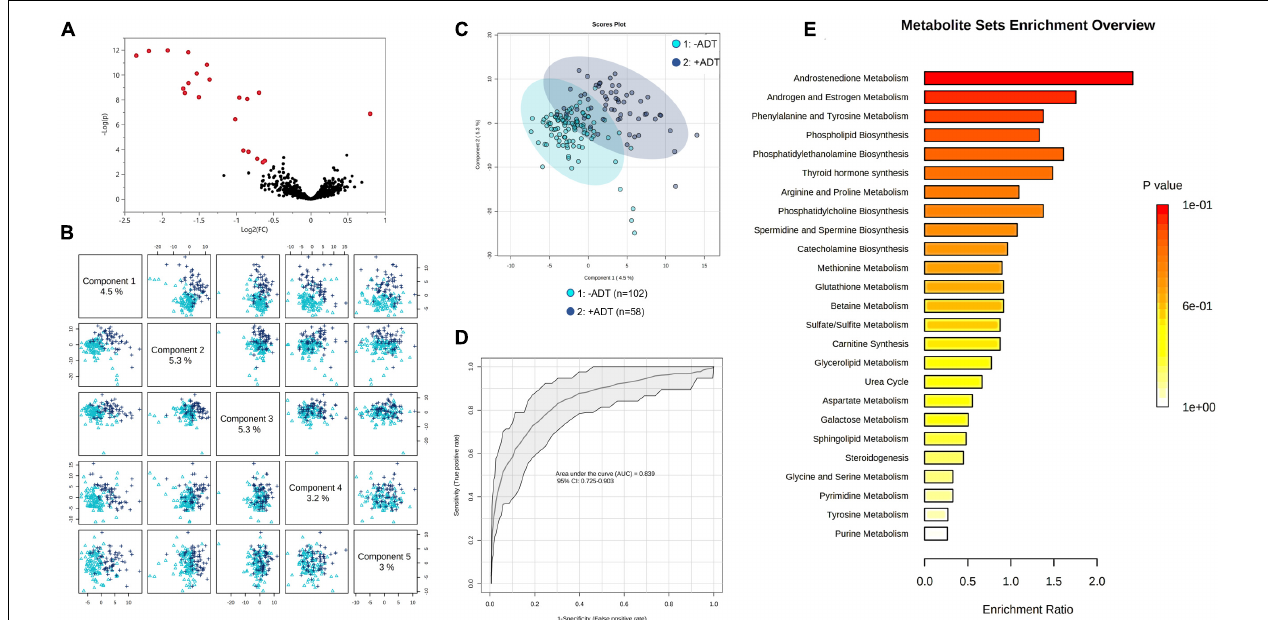
FIGURE 1 | Metabolic profiles of patients with non-metastatic prostate cancer with (+ADT, n = 58) or without androgen deprivation therapy ( − ADT, n = 102). (A) Volcano plot of metabolites of the +ADT group compared to − ADT. The y axis represents p -value converted to negative log 10 scale, and the x axis represents log2 fold change. Significant metabolites (fold change > 1.5, FDR ≤ 0.1) were highlighted in red. (B) Pairwise PLSDA score plot of the top five components. (C) PLSDA two-dimensional plot ellipses representing 95% confidence intervals. (D) ROC curve demonstrating the specificity and sensitivity of the PLSDA